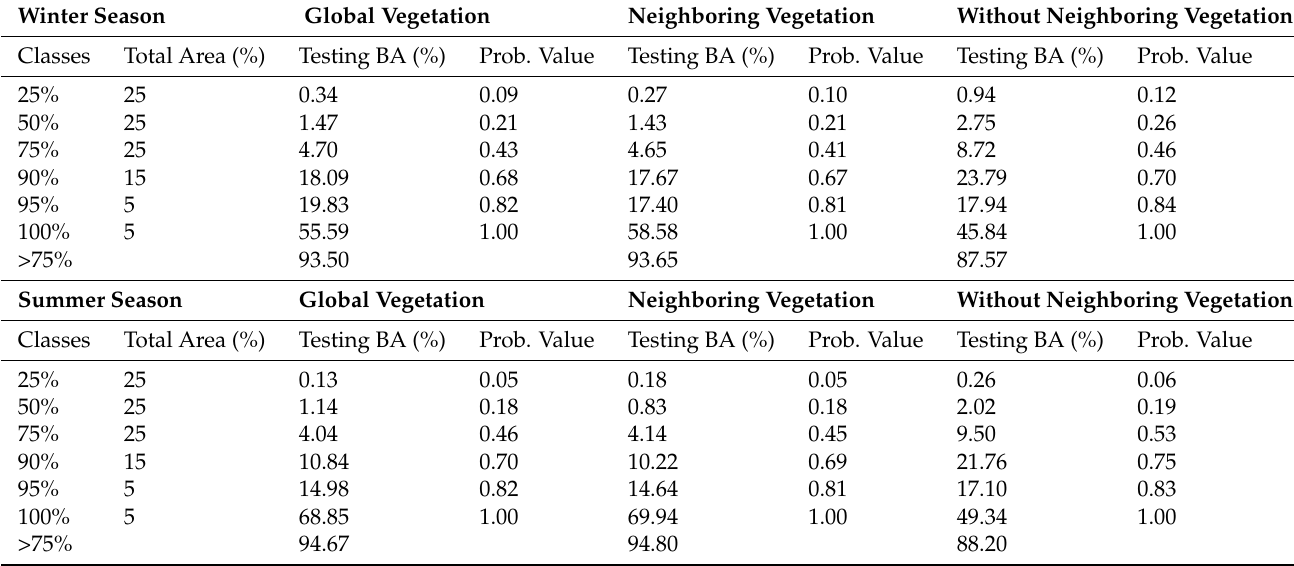
Table 4. Percentage of burned area in the testing subset belonging to different output percentile classes for RF with different vegetation models. The last line for each season represents the top 25%